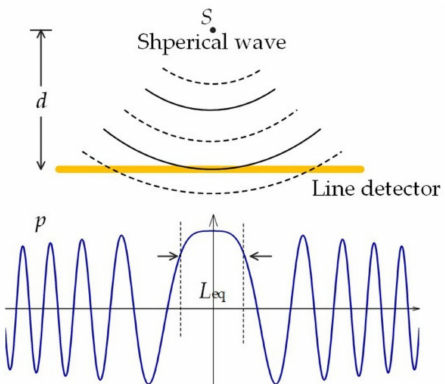
Figure 7. Schematic of the fiber laser sensor as an ideal line detector. A point source emits a spherical wave and the detected acoustic pressure distribution along the line detector. Figure adapted with permission from Ref. [45].